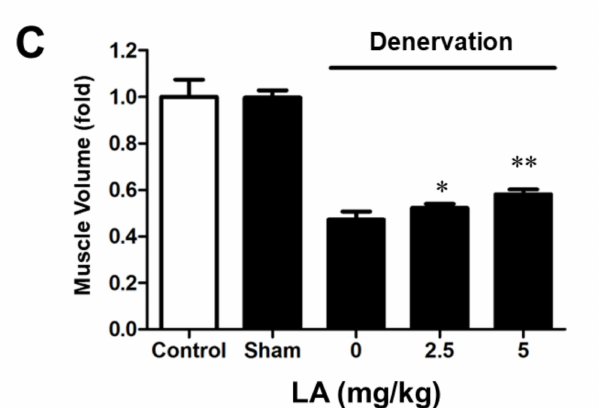
Figure 5. Linoleic acid treatment prevents denervation-induced muscle atrophy in C57BL/6 mice. ( A ) Muscle atrophy was induced in C57BL/6 mice by sciatic denervation. Evaluation of muscle volume and analysis of two-dimensional (2D) and three-dimensional (3D) models were conducted 21 days after sciatic denervation. LA (0–5 mg/kg) was administered by intramuscular injection. ( B ) Effects of LA on disuse atrophy by sciatic denervation in mice. ( C ) Evaluation of muscle volume after sciatic denervation. Evaluation of muscle volume after treatment with LA (0–5 mg/kg). Each value indicates the mean ± SD ( n = 6); * p < 0.05, ** p < 0.01 vs. sciatic denervation